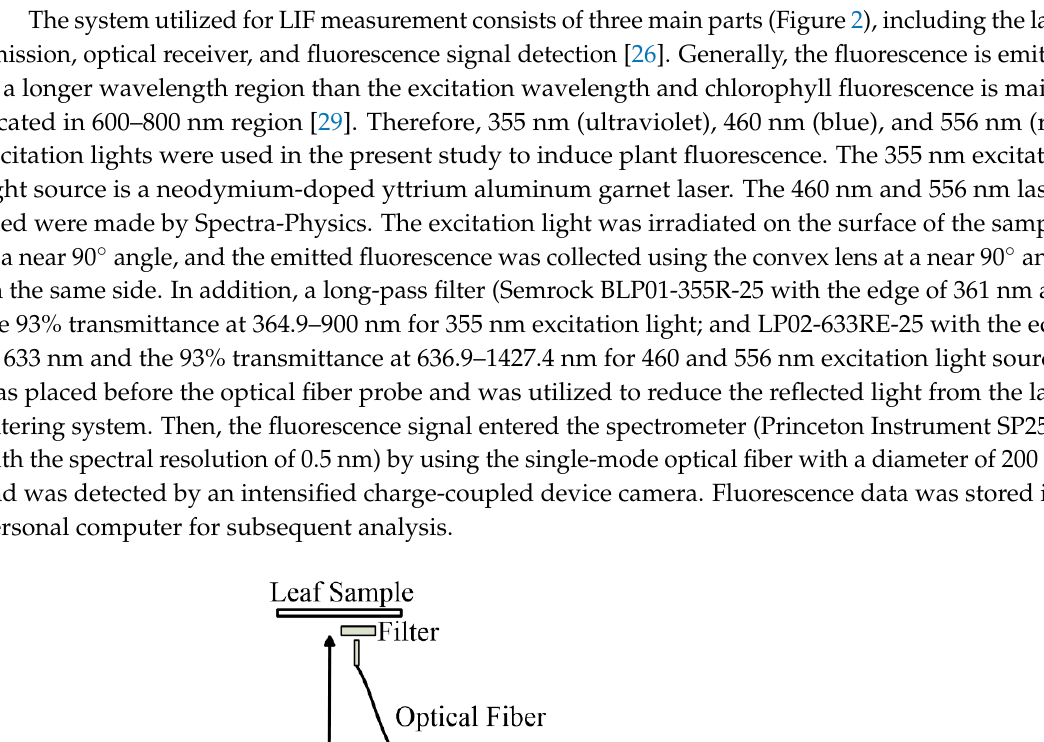
Figure 1. Location of experimental fields, Huazhong Agricultural University in Wuhan, Hubei province, China.